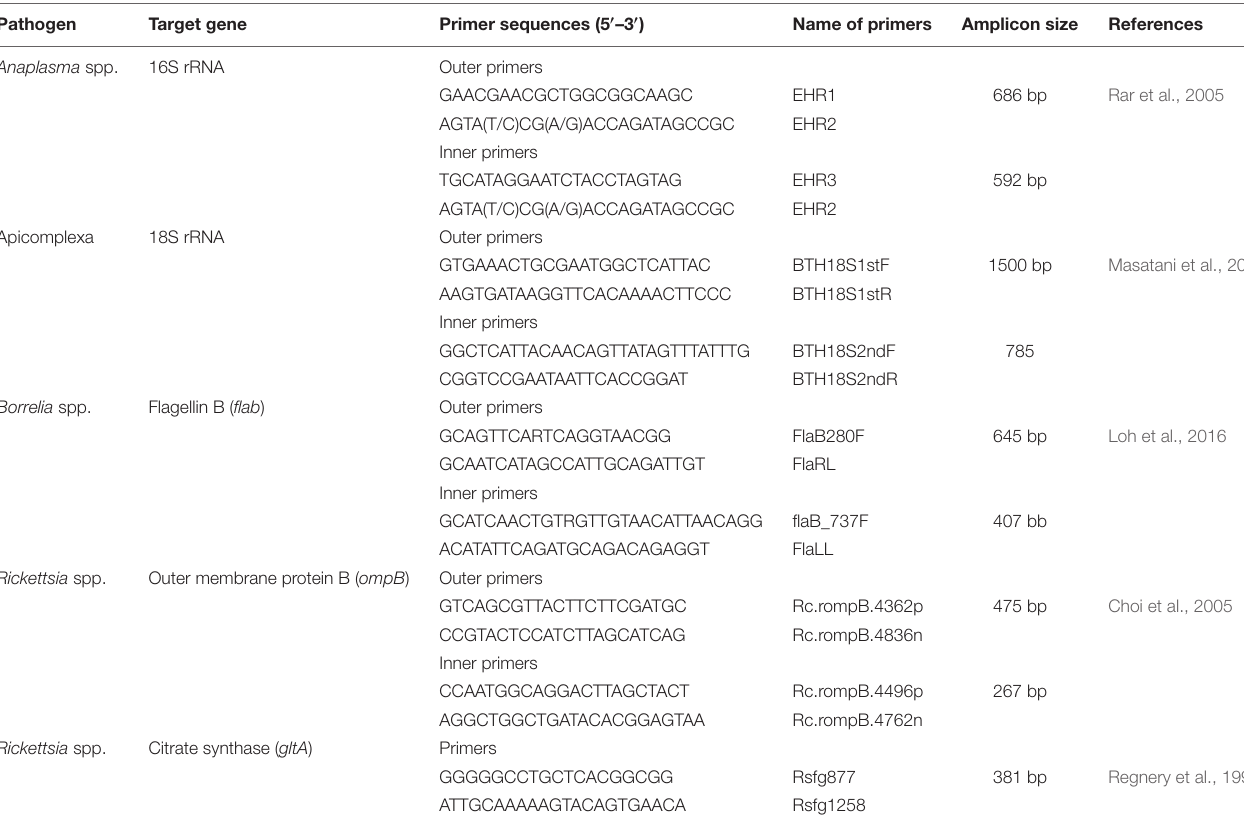
TABLE 1 | Set of primers used to validate microfluidic real-time PCR